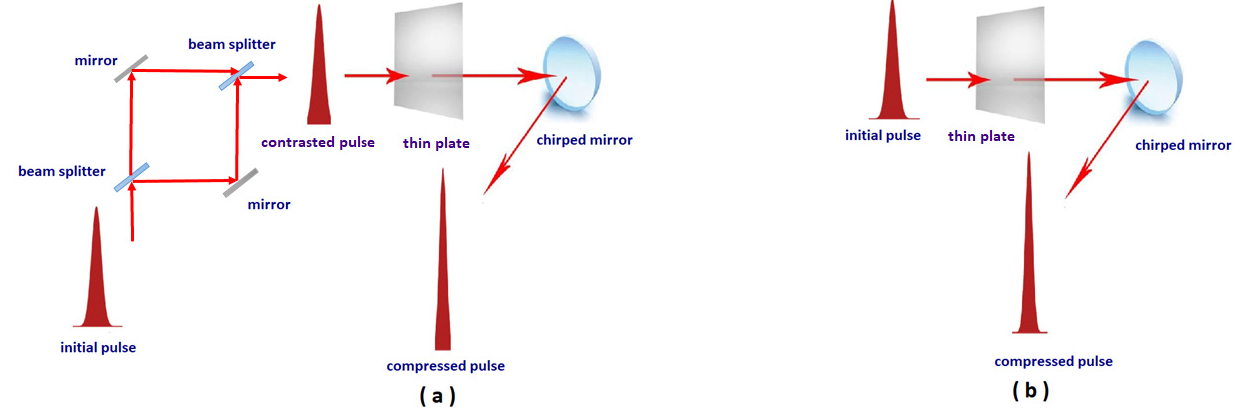
Figure 1. Optical schemes with nonlinear Mach–Zehnder interferometer ( a ) and without interferometer ( b ).